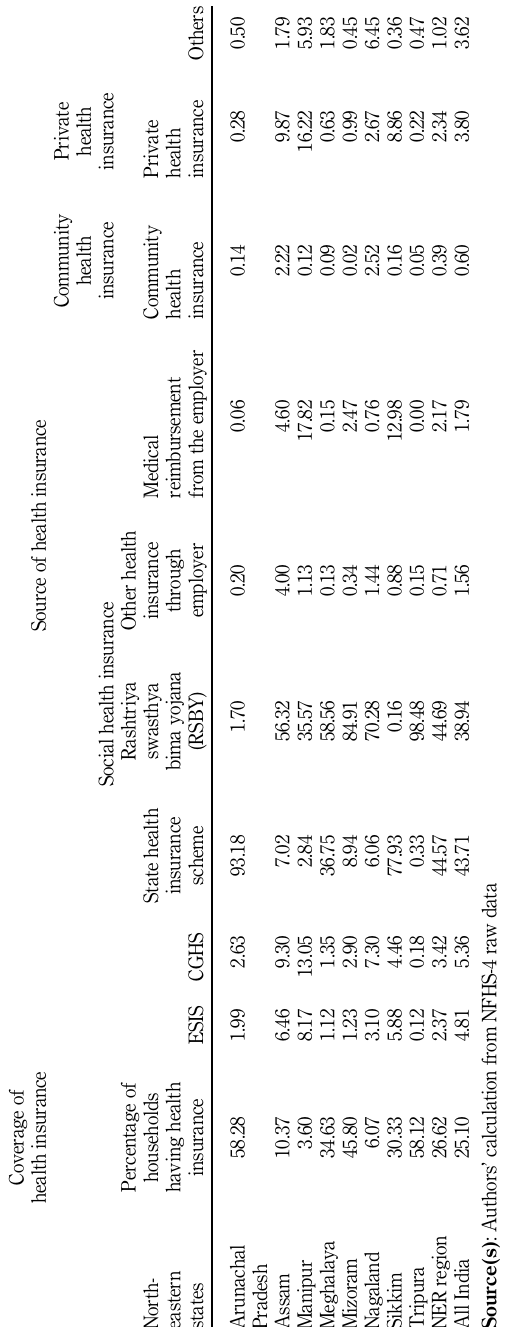
Table 1. Distribution of health insurance coverage in the north-eastern region of